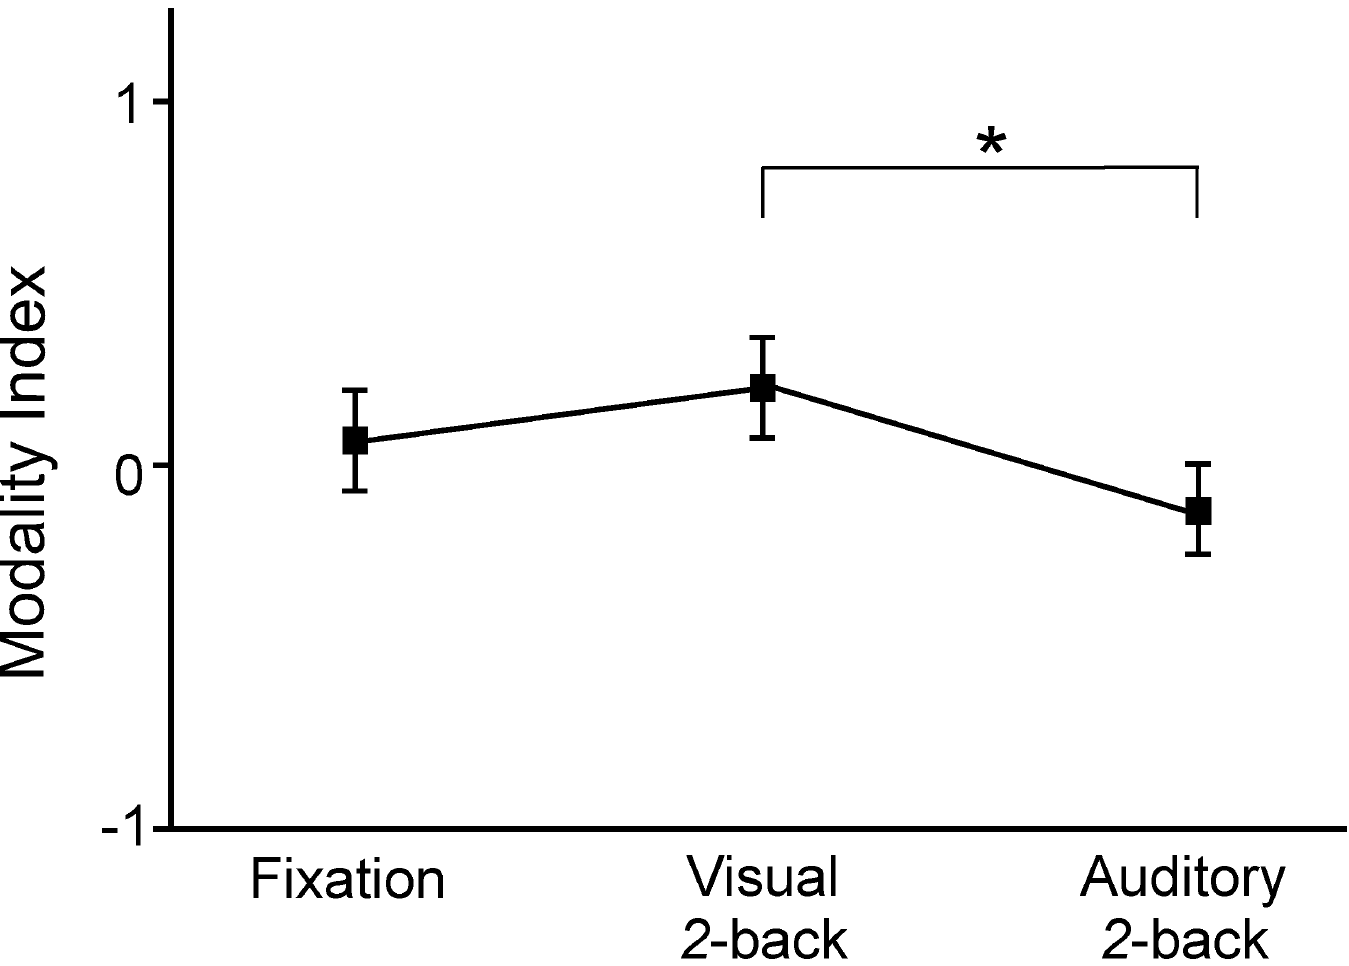
Fig 3. Observed relations between task modality and form of mind wandering. Modality index of -1 indicating mind wandering being always auditory and 1 being always visual. Error bars represent ± 1SE. Observationindicatedmind wandering is greater in the same modality as the concurrent task.